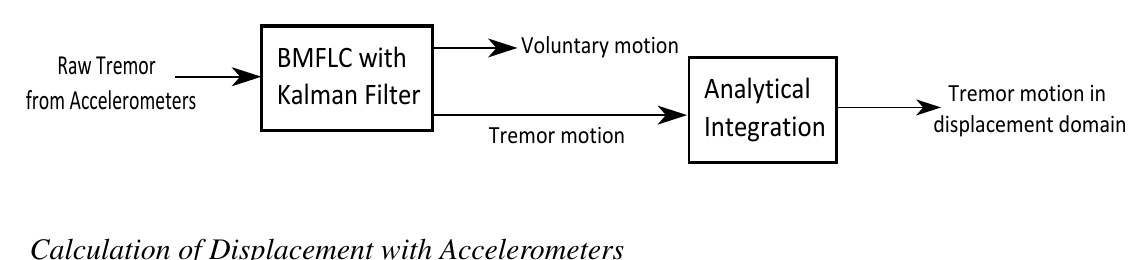
Figure 4. Block diagram for BMFLC-Kalman tremor